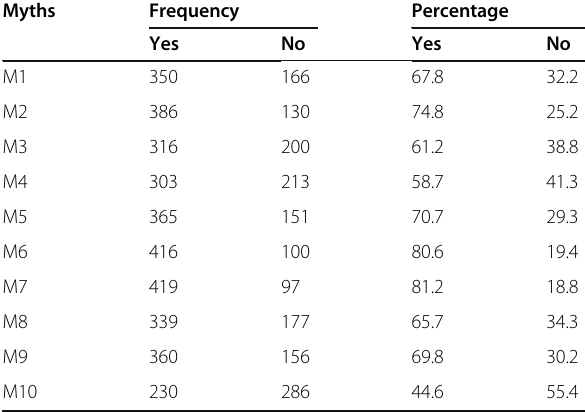
Table 3 Beliefs about LBP among the study participants